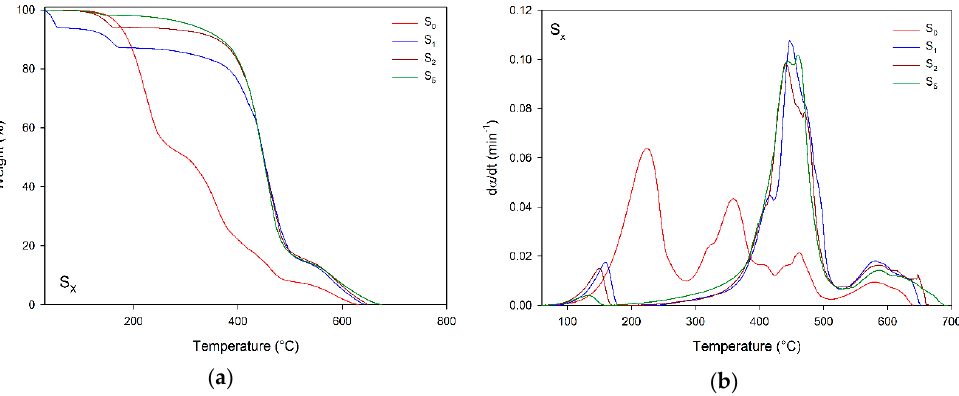
Figure 1. ( a ) TGA plots and ( b ) decomposition rate (d α /dt) of Synthetic (S X ) compounds—Benchmark. The TGA plots of epoxy/eggshell systems (E 10 , EM 10 , and M 10 ) presented a similar thermal behavior to that of benchmark S 0 , as shown in Figure 2. For these systems, four decomposition steps